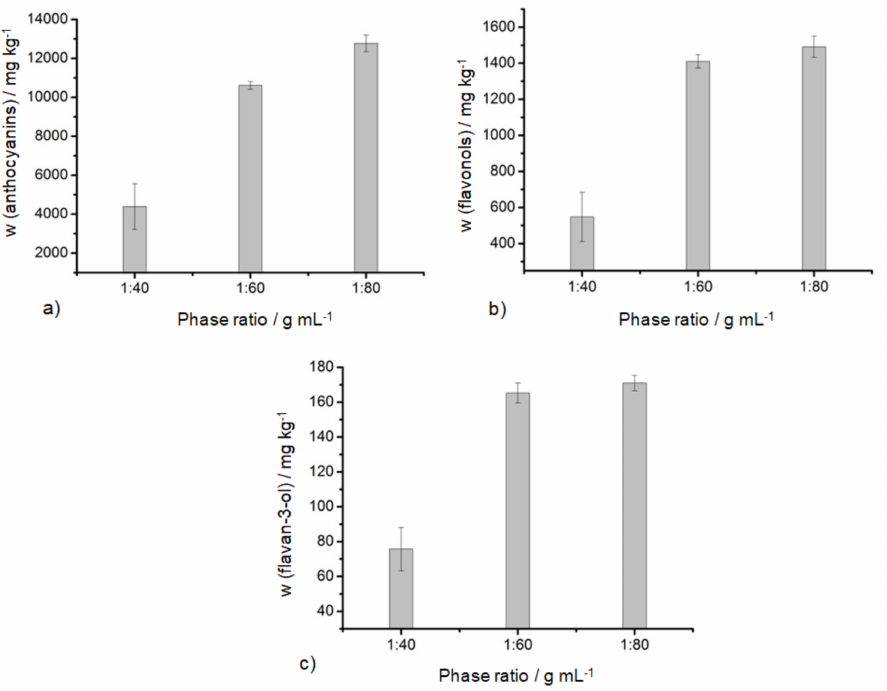
Figure 3. Dependence of the contents of ( a ) anthocyanin, ( b ) flavonol, and ( c ) flavan-3-ol on the solid-to-solvent